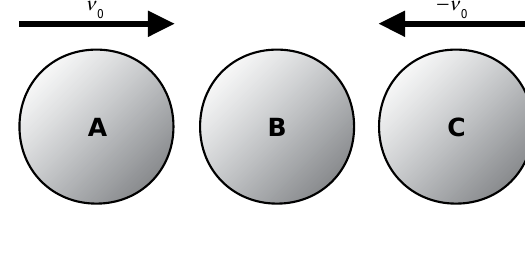
Fig. 3 3-particle contact problem